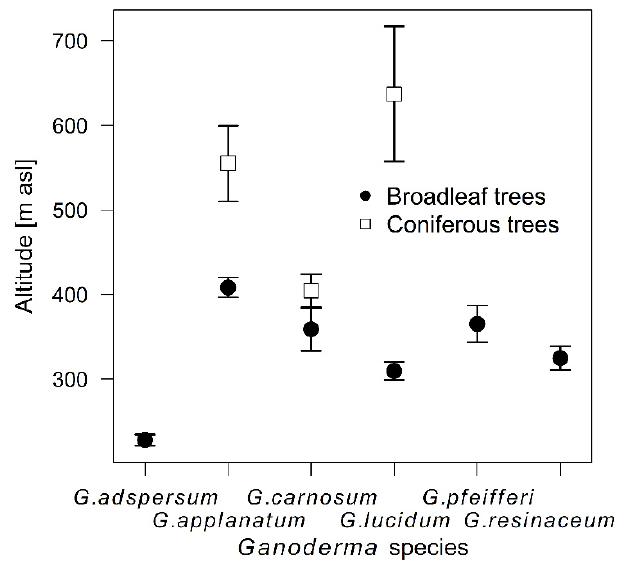
Figure 2. Average altitude of samples of individual Ganoderma species on broadleaf and coniferous trees (mean ± SE).